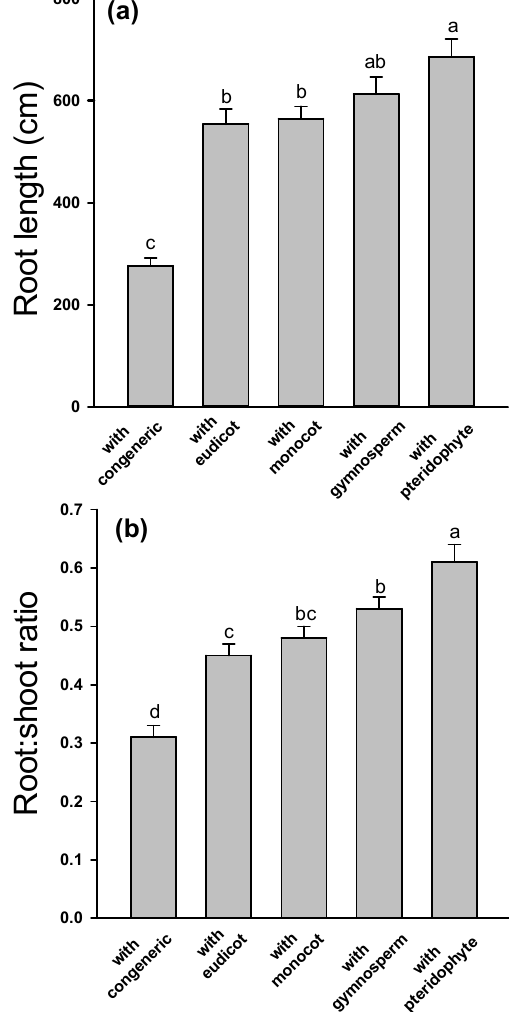
Figure 5. ( a ) Root length and ( b ) root:shoot ratios of Serianthes grandiflora seedlings grown with dif- ferent species. Treatments were: congeneric, Serianthes kanehirae ; eudicot, Tabernaemontana pandacaqui; monocot, Pogonatherum crinitum ; gymnosperm, Cycas nitida ; pteridophyte, Pityrogramma calomelanos . Root:shoot ratios based on dry weight. Bars represent one SE ( n = 6) and bars with the same letters are not significantly different.